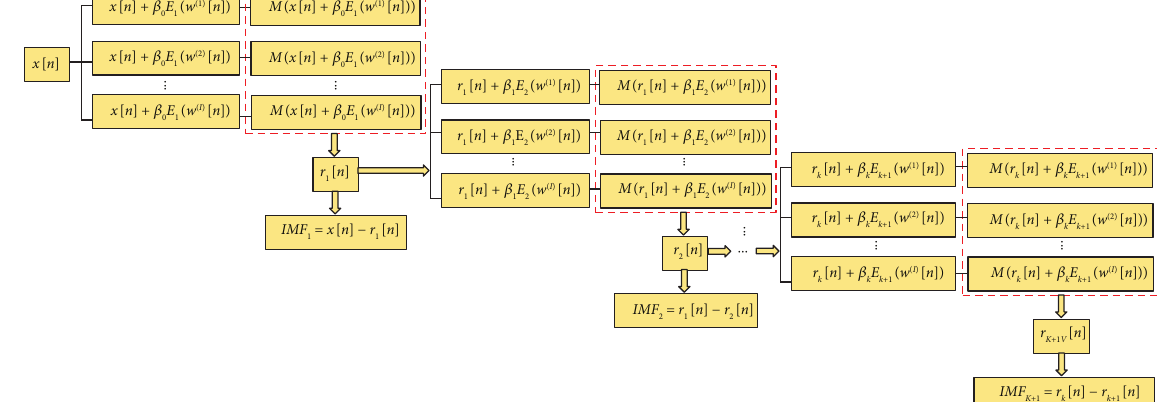
Figure 1: Flowchart of the ICEEMDAN algorithm [5,